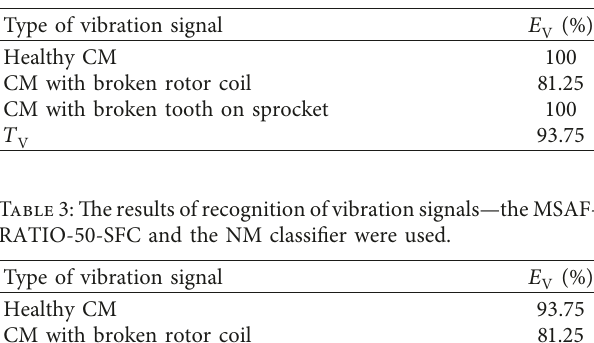
Table 2: The results of recognition of vibration signals—the sum of RSoV and the NM classifier were used.